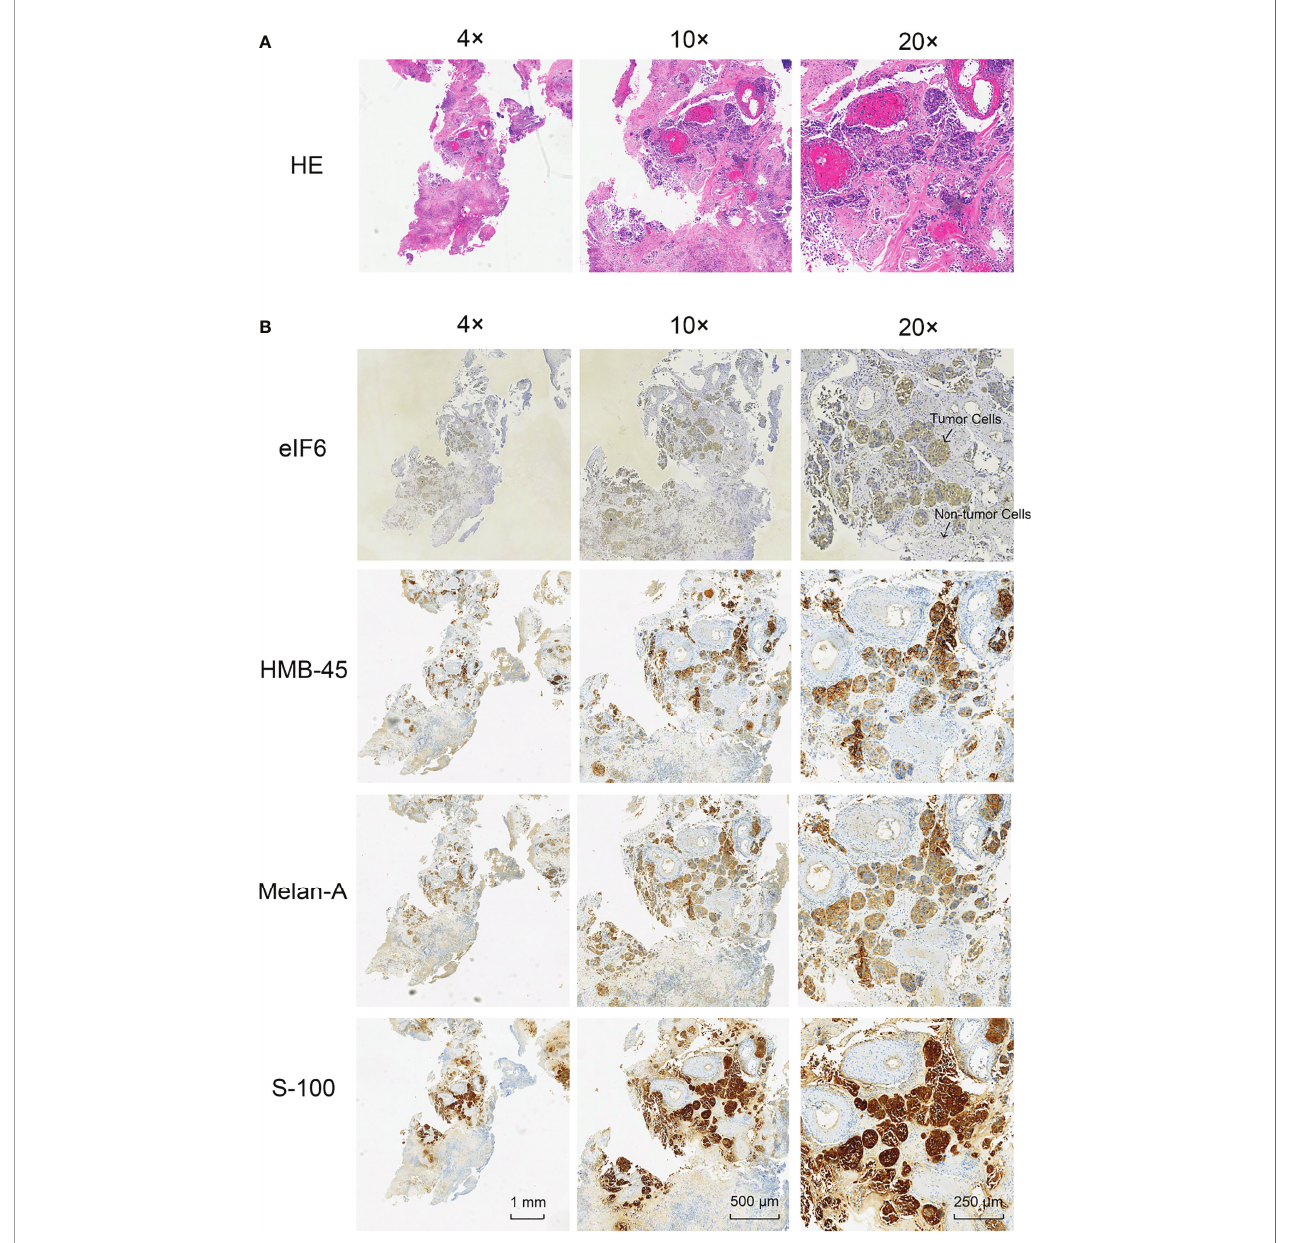
FIGURE 2 | Histological examination of the tumor specimens (Area size: 0.5 cm 2 ). (A) Hematoxylin-eosin staining (H&E) shows the histology of melanoma tumor. (B) Immunohistochemical staining of eIF6, HMB-45, Melan-A, and S-100 in melanoma tumor slices,